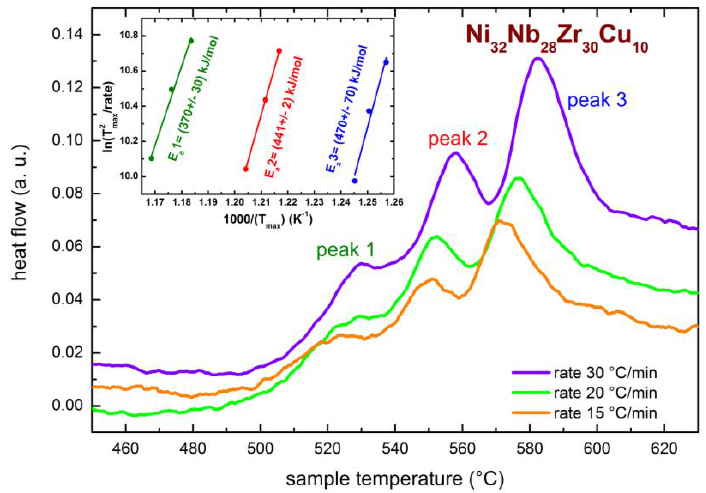
Figure 1. DTA signal measured at different heating rates. The inset reports the Kissinger plot for the three thermally activated peaks shown by the DTA curves.